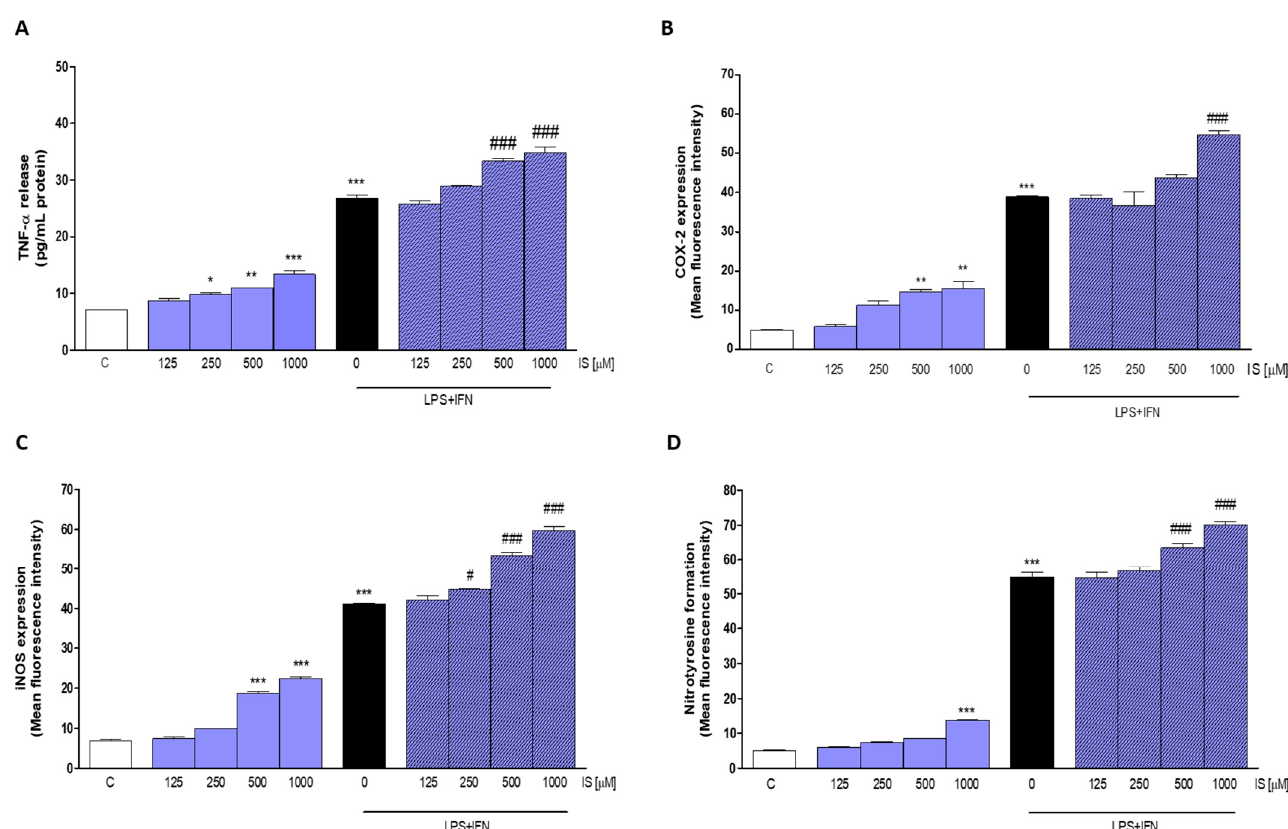
Figure 4. Effect of Indoxyl Sulfate (IS; 125–1000 µM) on pro-inflammatory mediators in lipopolysaccharide (LPS) + interferon- γ (IFN)-treated IEC-6 cells. TNF- α release ( A ), evaluated by ELISA assay, COX-2 ( B ) and iNOS ( C ) expression and nitrotyrosine formation ( D ), evaluated by the cytofluorimetric technique. Data are expressed as pg/mL or mean of fluorescence intensity. C denotes control group. ***, ** and * denote respectively p < 0.001, p < 0.01 and p < 0.05 vs C; ### and # denote respectively p < 0.001 and p < 0.05 vs LPS + IFN.